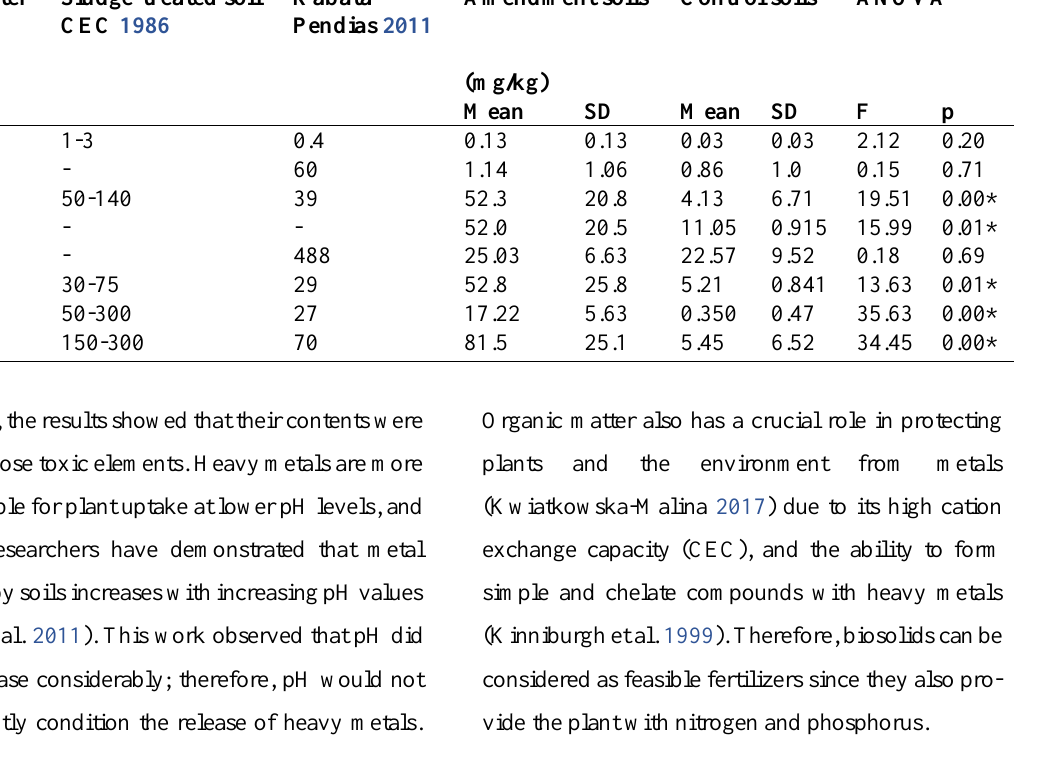
Table 3 Micronutrients and metals in the amended soils after harvest and reference values, * p<0.05